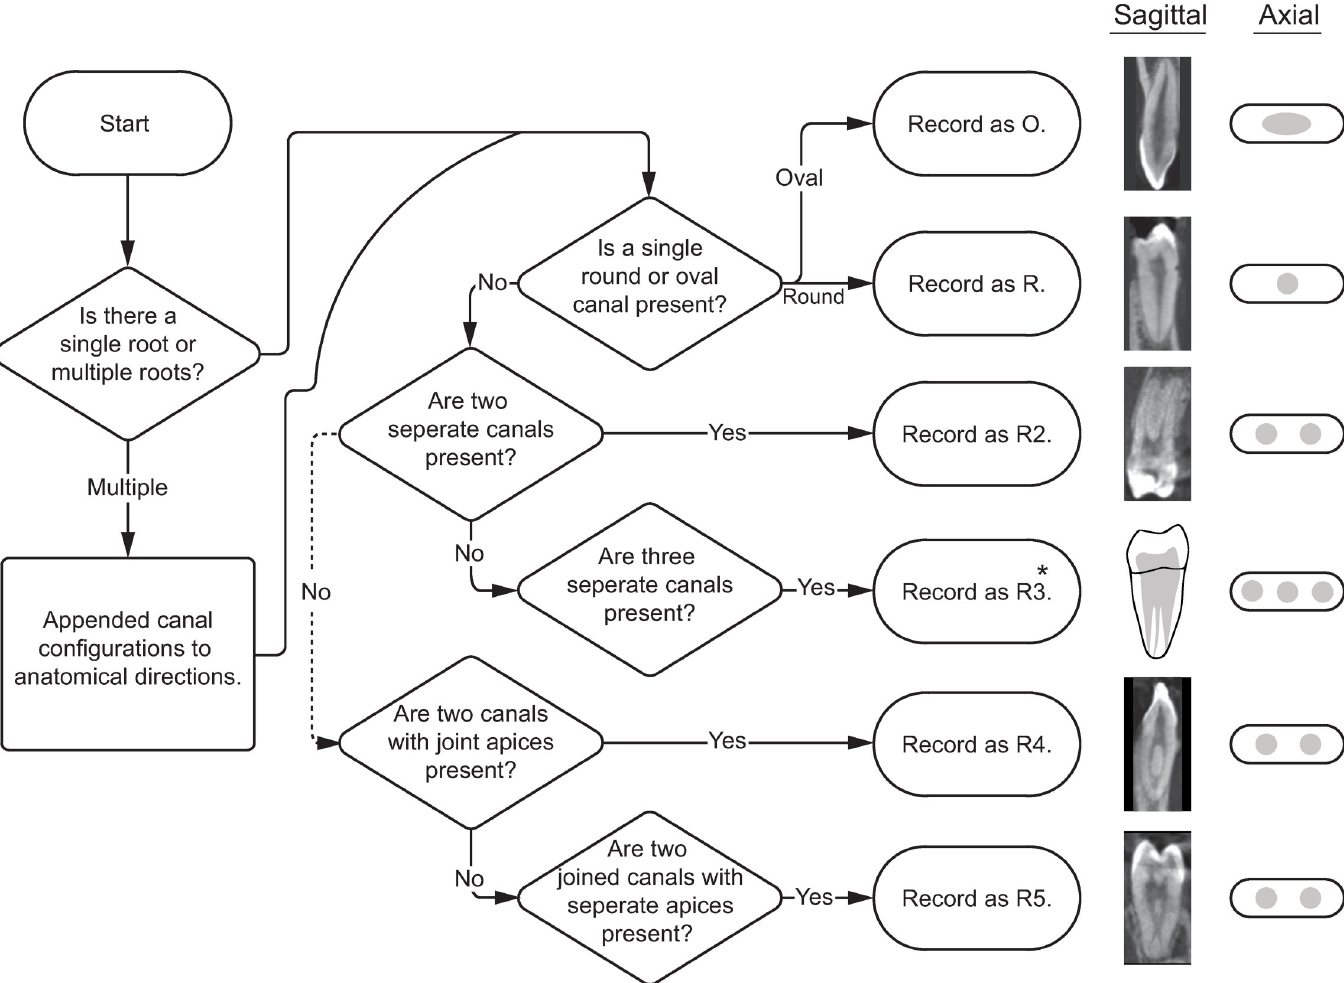
Fig 17. Flow chart for determining and recording phenotype element 5—canal morphology and configuration. Right: sagittal CT slices showing canal morphologies. � Because the R3 variant does not appear in this sample, the sagittal slice is represented by an illustration.